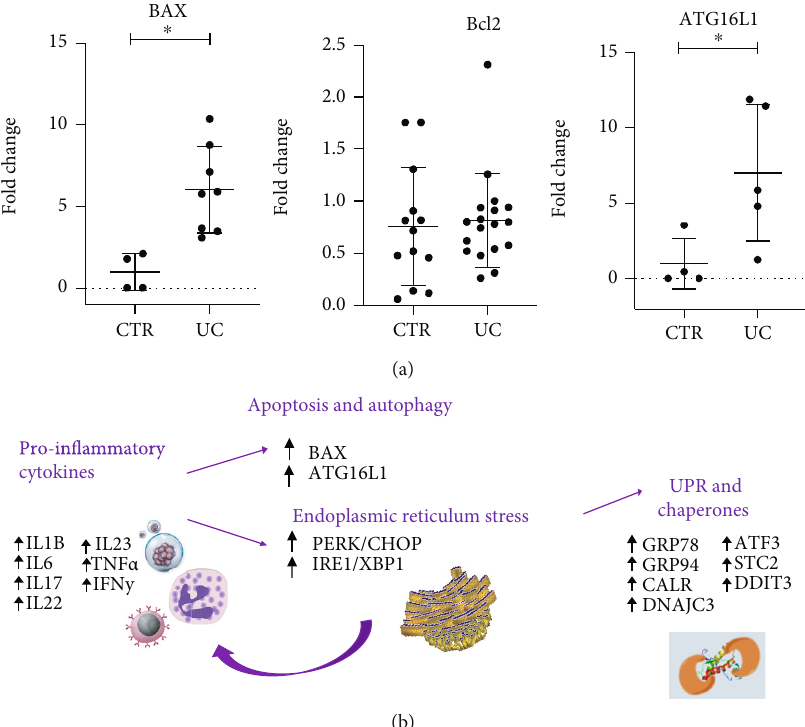
Figure 4: Apoptosis and autophagy are modulated in UC patients. (a) Transcriptional levels of BAX, Bcl-2, and ATG16L1 as determined by qPCR are shown as a fold change, ∗ p < 0 : 05 . UC =ulcerative colitis; CTR=control. (b) Illustrated chart of our results showing alterations in the pathways involving in fl ammation, ER stress, autophagy, and apoptosis markers in UC